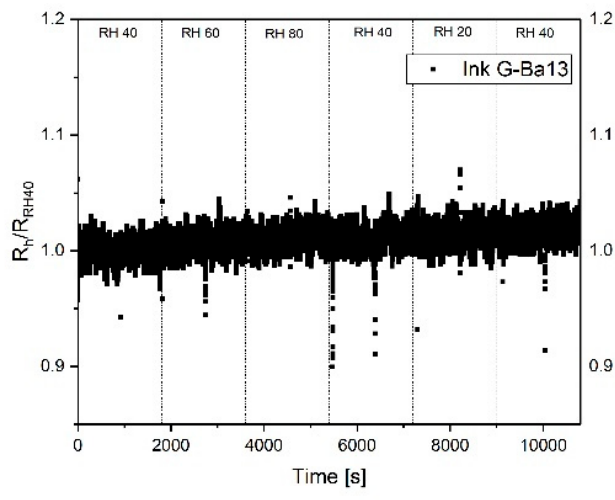
Figure 5. Normalized response of sensor S 2 towards different relative humidity. The sensor was heated up to 250 °C and kept at this temperature during the measurements.